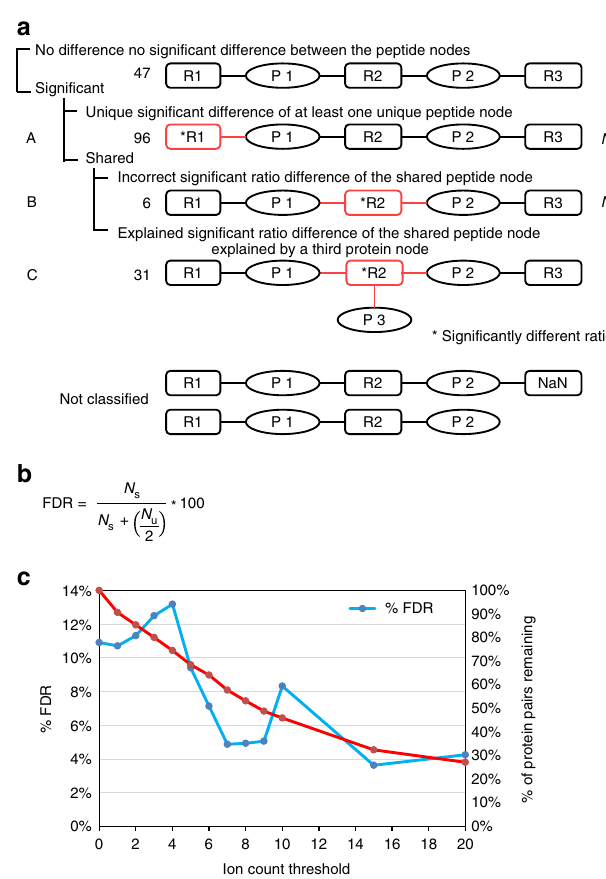
Fig. 6 Classi fi cation of protein pairs based on user-de fi ned settings and FDR calculation. a Protein pairs can be differentiated depending on whether unique or shared peptide nodes are signi fi cantly regulated, for example, are differentially expressed by more than a user-de fi ned threshold. Signi fi cantly altered peptide ratios are outlined in red and connected to the corresponding protein node by an edge in red. Shared peptide nodes are not expected to be signi fi cantly regulated (incorrect) unless the shared peptide node connects to more than two protein nodes (explained). Protein pairs were not further considered in case a peptide node was missing or not determined (not classi fi ed). b An FDR is calculated according to the equation depicted. The number of protein pairs that include a shared peptide group that is signi fi cantly regulated ( N s ) is used to estimate the number of falsely discovered protein pairs that include at least one signi fi cantly regulated unique peptide group ( N u ). c The plot shows the relationship between number of protein pairs detected and corresponding FDR to ion count threshold settings. Abbreviations: P: protein, R: